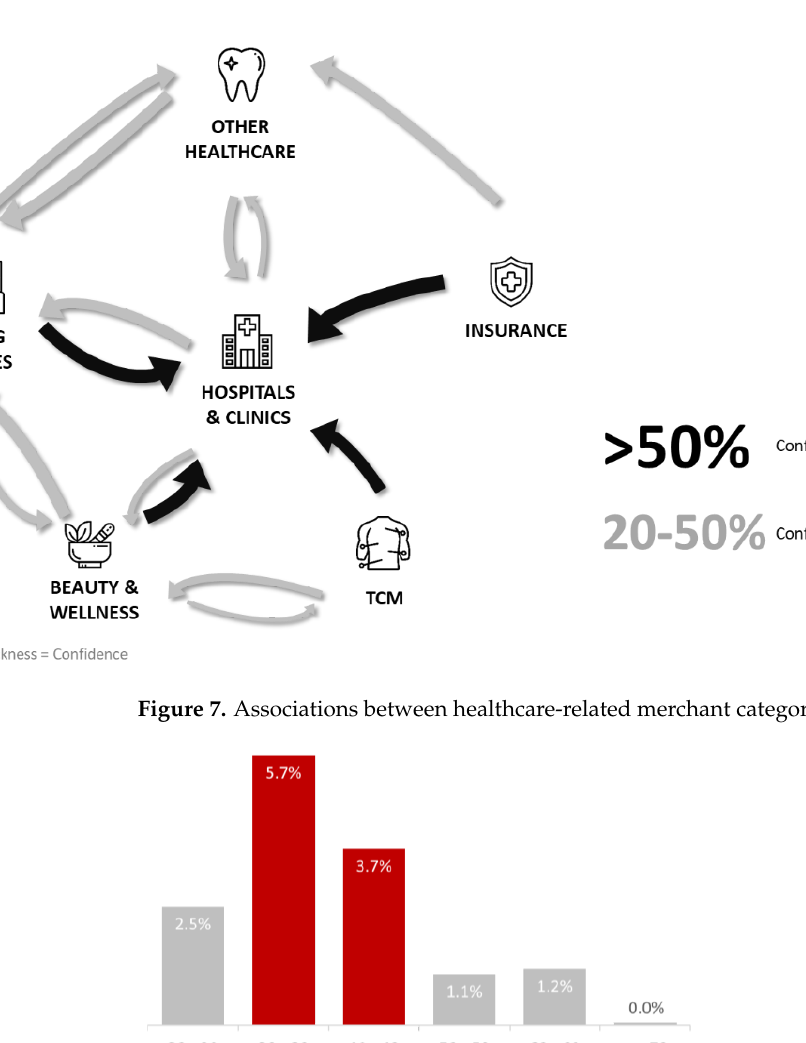
Figure 8. ‘ Women and Kids ’ spending by age band .